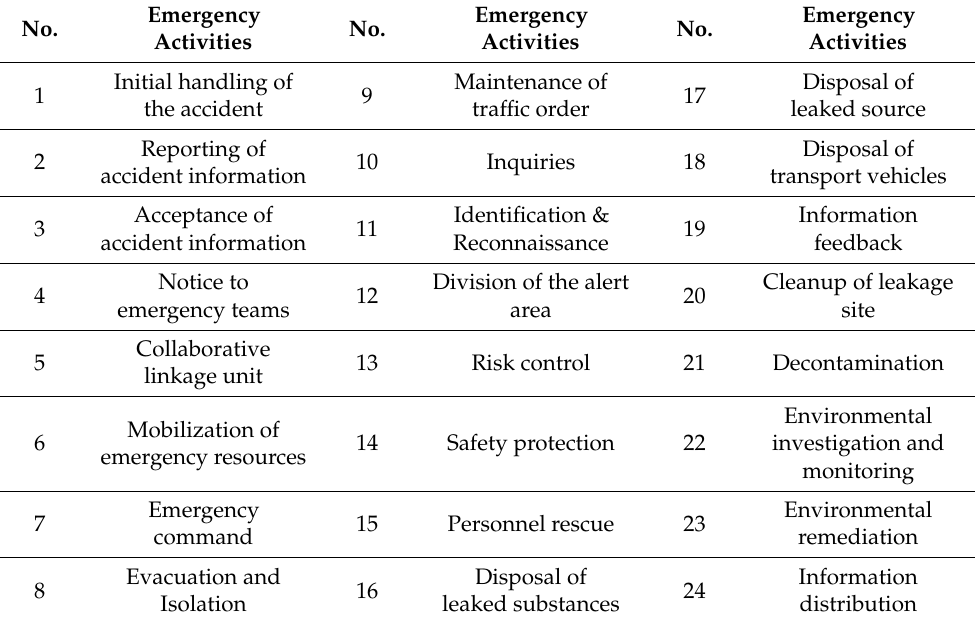
Figure 4. Emergency activities map of road transportation leakage accidents of hazardous chemicals. Table 3. Emergency activities of road transportation leakage accidents of hazardous